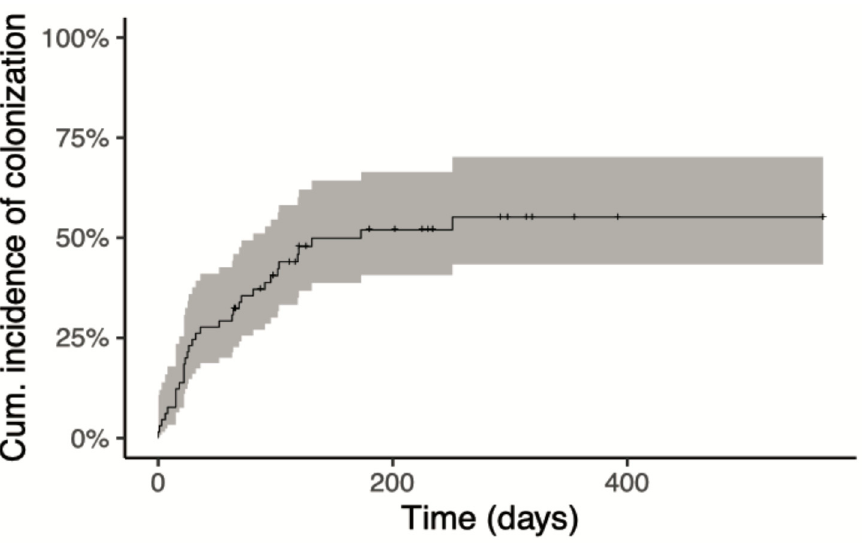
Figure 1. Cumulative incidence of colonization by multi-resistant Gram-negative bacteria.